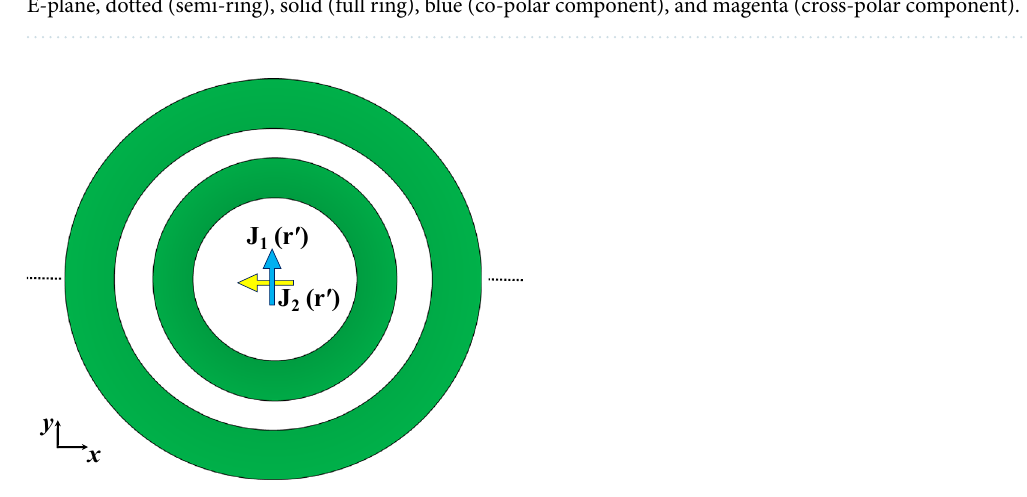
Figure 14. Radiation patterns for the proposed structure in Fig. 13 at 20 GHz, left (H-plane), and (right) E-plane, dotted (semi-ring), solid (full ring), blue (co-polar component), and magenta (cross-polar component).